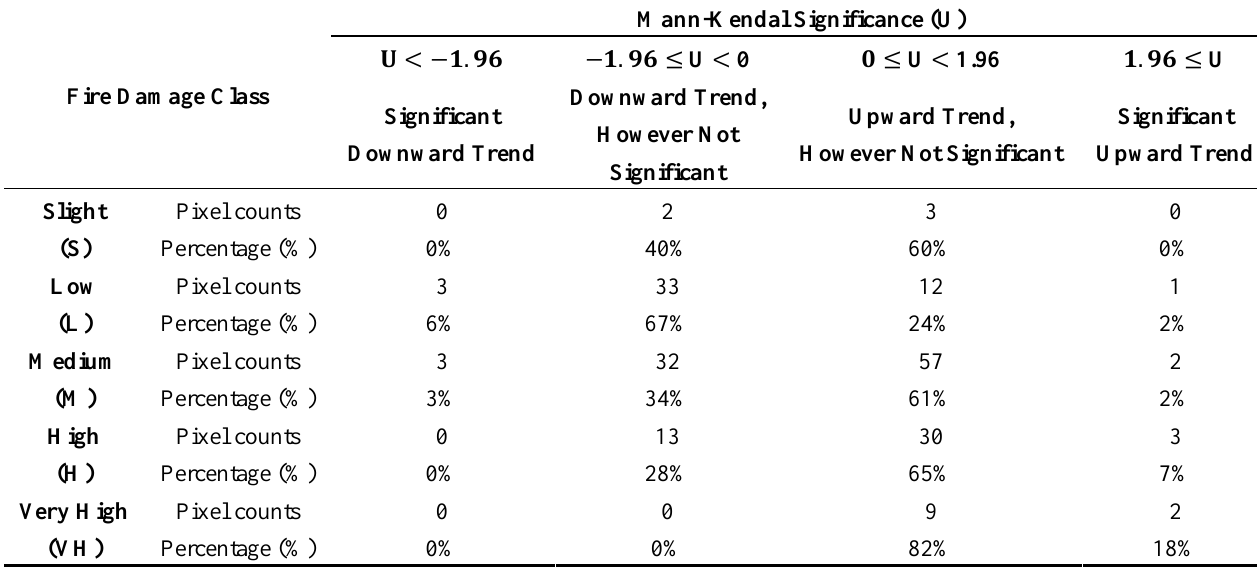
Table 4. The degree of significance for the post-fire stands regrowth index (SRI) trends using a non-parametric Mann-Kendall